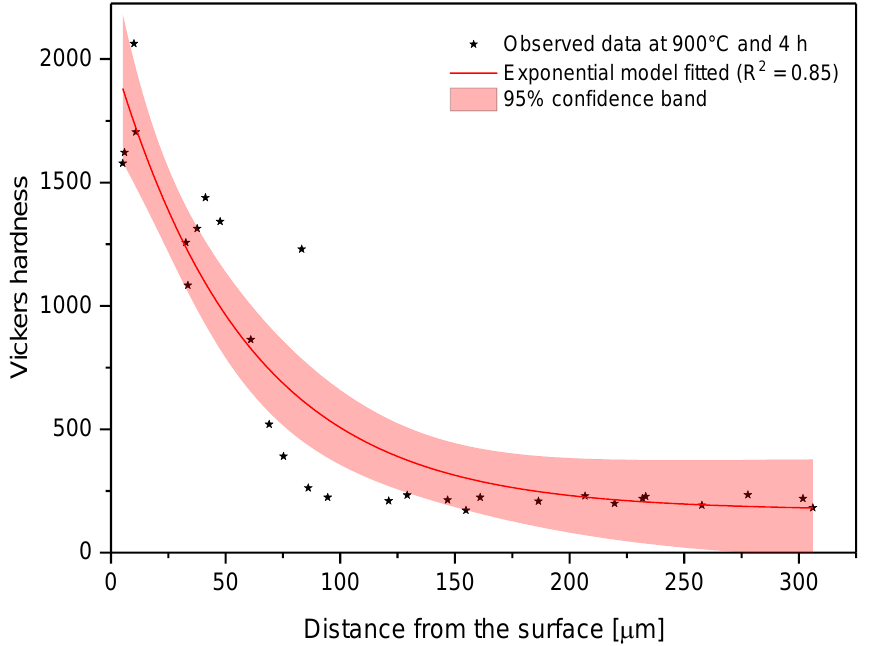
Figure 9. Changes in microhardness as measured away from the surface for a sample treated at 900 °C and 4 h.